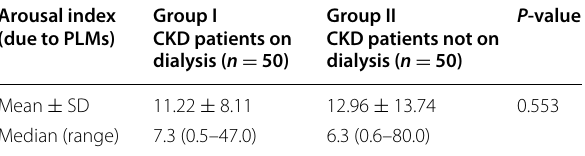
Table 4 Arousal due to PLM in both groups of CKD patients Arousal index (due to PLMs)